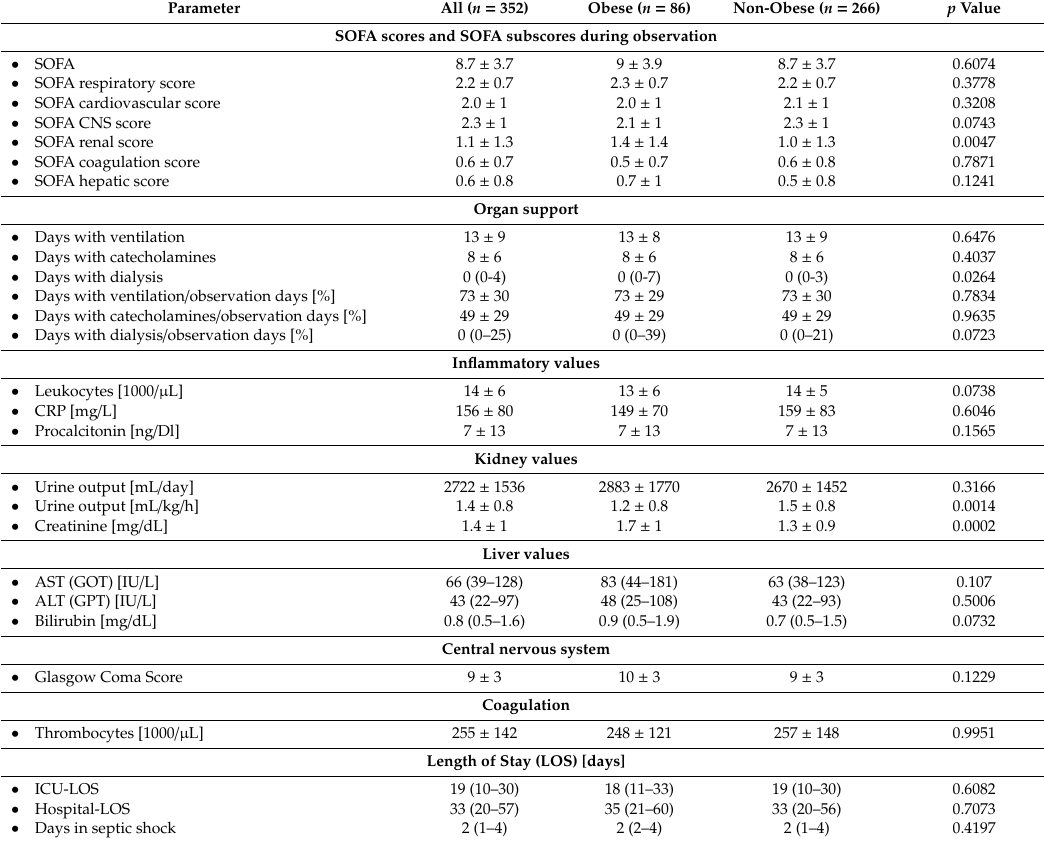
Table 2. Disease severity with respect to obesity category.